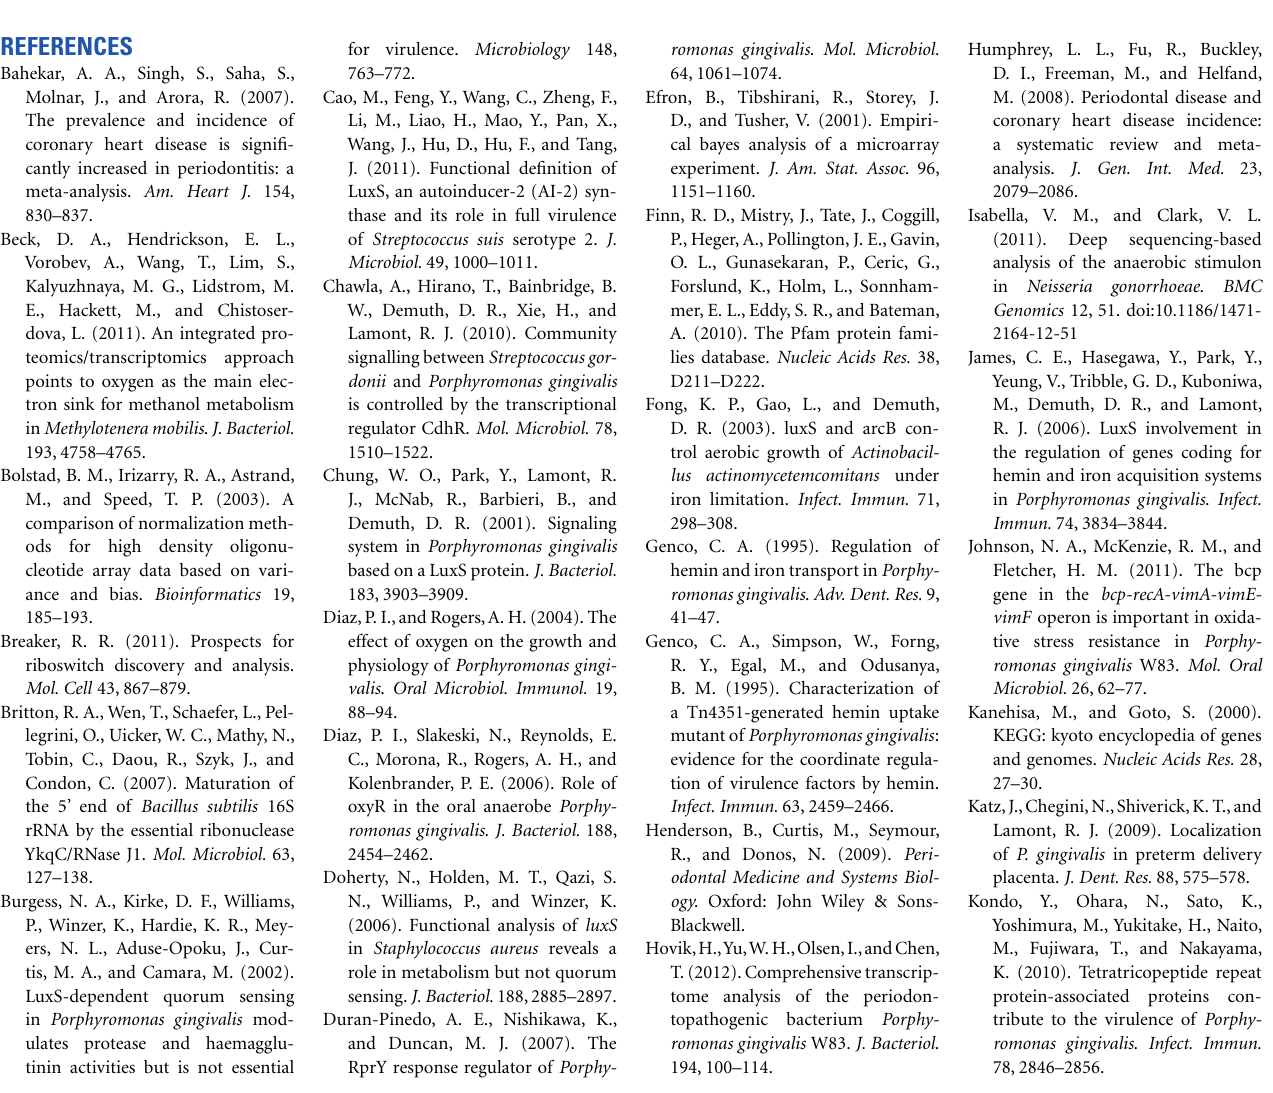
show down-regulation or up-regulation, respectively, of genes in ∆ luxS compared toWT.When statistically significant, the bars for up-regulation or down-regulation of ∆ lux relative toWT are colored red or green, respectively. Figure S2 |Wild-type vs. ∆ luxS by RPKM method. RPKMs of genes in the ∆ luxS mutant were compared to those ofWT. Fifty-seven ORFs were differentially expressed with a p -value threshold of 0.05. Red and green show up and down-regulation in the ∆ luxS strain relative toWT, respectively. Statistical significance is indicated from dark to light with increasing significance. Figure S3 | Pathway analysis for differentially regulated genes in ∆ luxS strain. Differentially expressed genes were mapped to the KEGG pathway the ∆ luxS mutant relative toWT, respectively. Statistically significant relative abundance changes are shown from dark to light with increasing significance. Figure S4 | Un-normalized log 2 per base coverage of the luxS (PGN_1474) in RNA-Seq. In gray are the wild-type samples and in green the ∆ luxS strain.The deleted region is clearly shown as the uncovered region in the ∆ luxS strain.The base numbering is relative to the 3 (cid:48) end of the ORF. Of note is the consistency of the sequencing depth profile between the three replicates for each